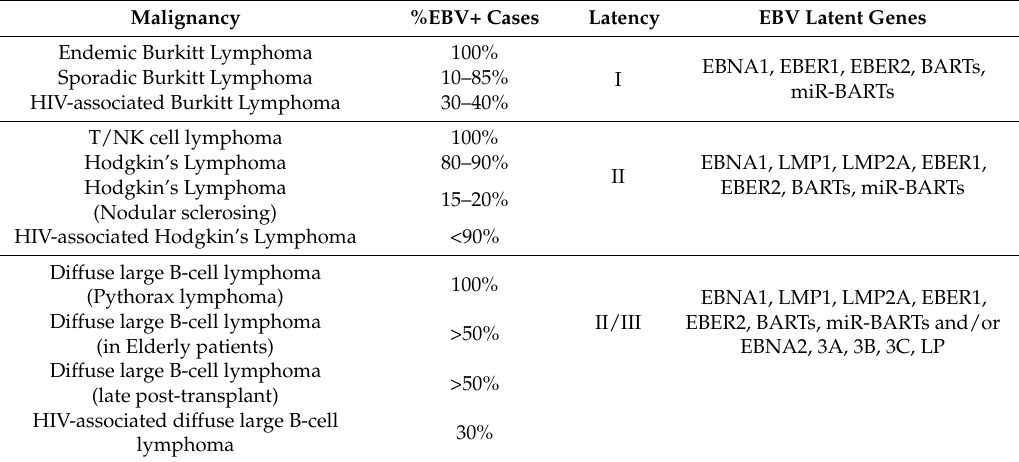
Table 1. Characteristics of Epstein-Barr virus (EBV)-associated